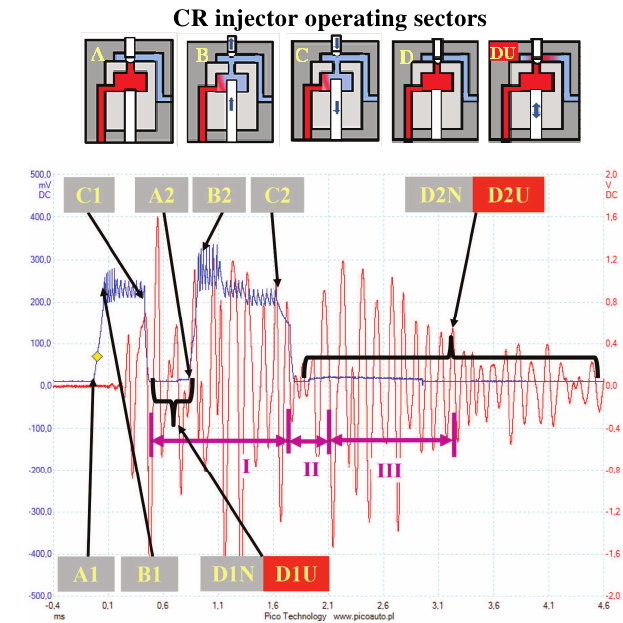
Fig. 3. Simplified schematic of the acoustic emission measurement track